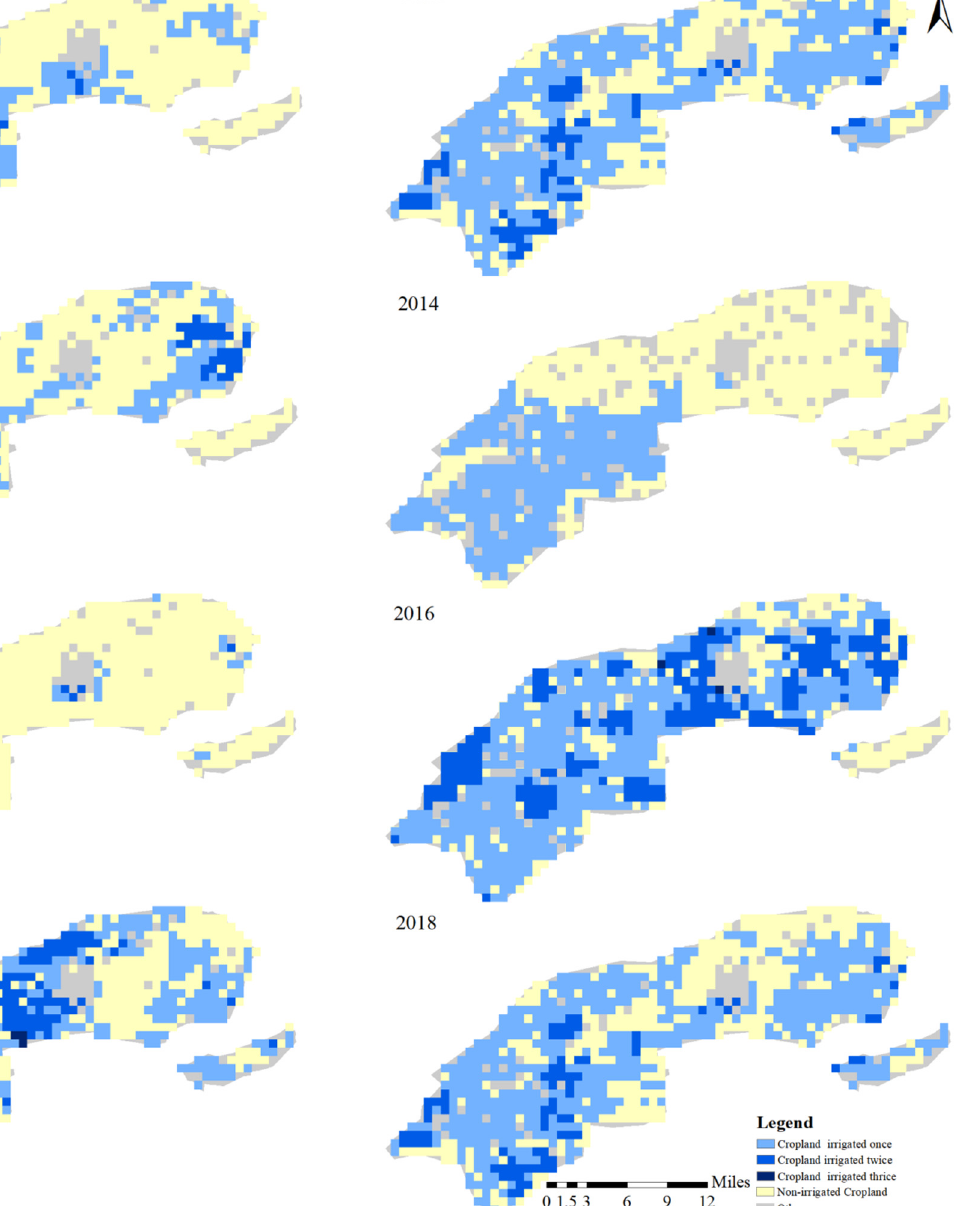
Figure 10. Irrigation intensity and spatial distribution of irrigation districts in spring irrigation in the study area from 2011 to 2018.